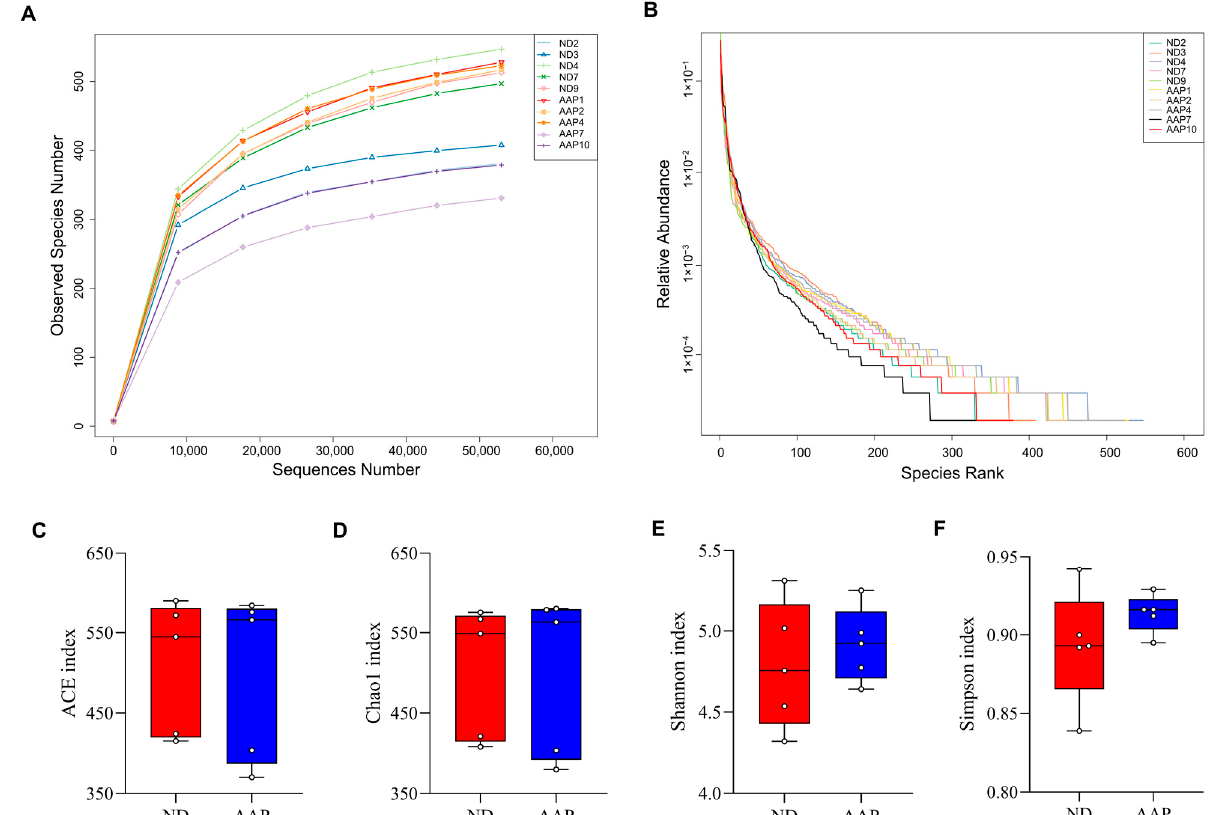
Figure 1. The effects of Auricularia auricula polysaccharides on α diversity of intestinal flora in mice. ( A ) Dilution curve; ( B ) Rank Abundance curve; ( C ) Group difference box diagram of the ACE index; ( D ) Chao 1 index; ( E ) Shannon index; ( F ) Simpson index. ND = normal diets; AAP = Auricularia auricula polysaccharides. Data presented as mean ± SD, n = 5.